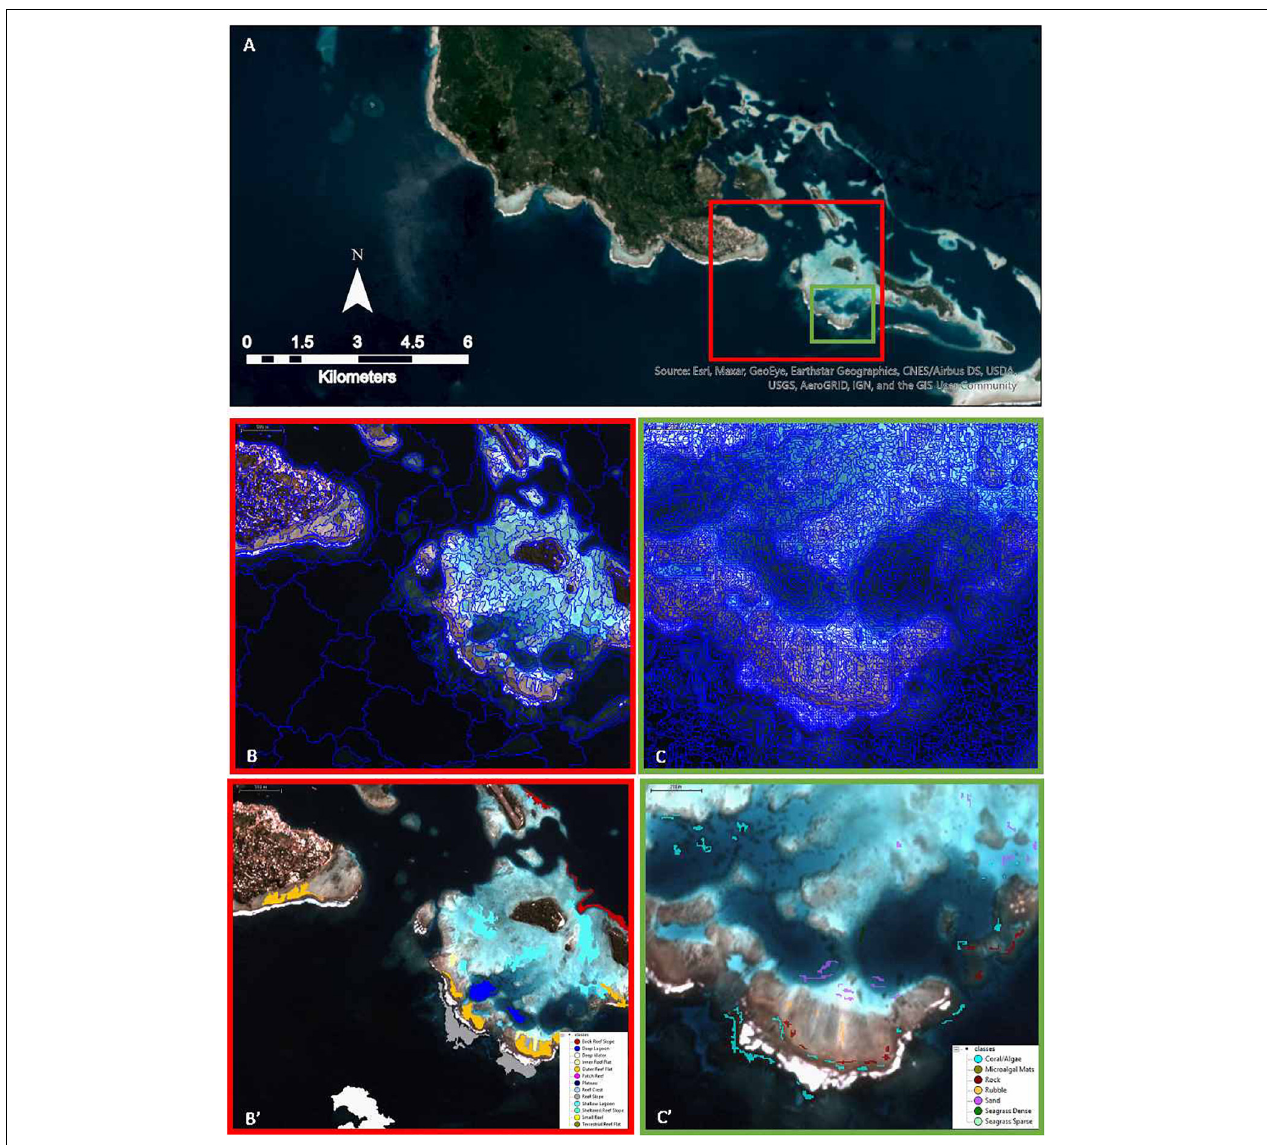
FIGURE 3 | The creation of reference data segments. (A) A representative Planet Dove image quadrat tile was segmented into interpretable groups of pixels (segments depicted by blue lines) at the (B) geomorphic and (C) benthic scale, using the object-based analysis software Trimble eCognition. Respective segments were assigned (B’) geomorphic, or (C’) benthic